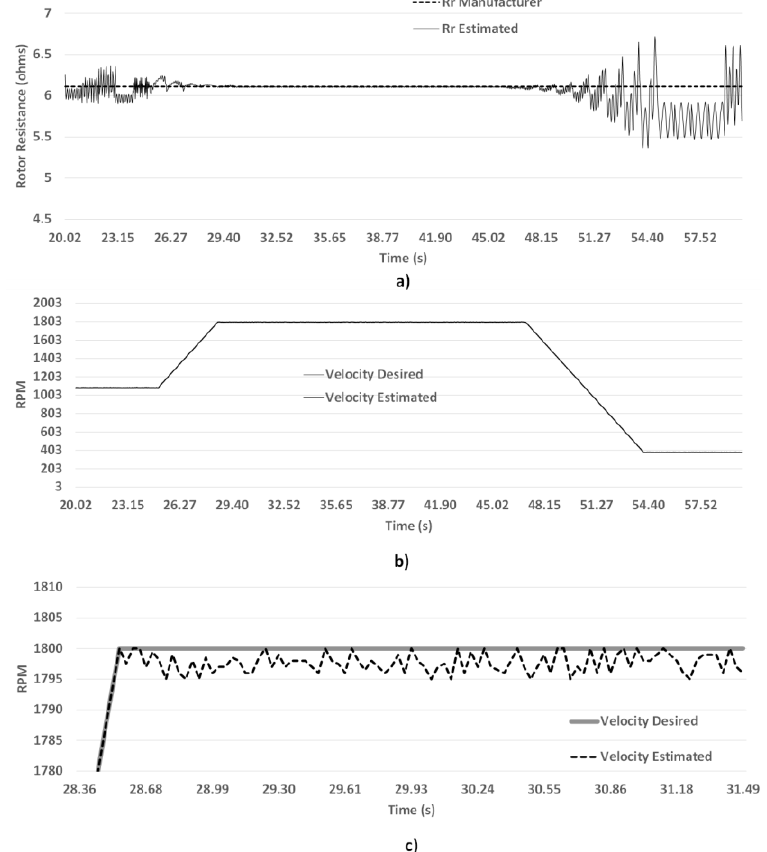
Figure 9. ( a ) Estimated R r vs. Desired R r ; ( b ) Estimated ω r vs. Desired ω r ; ( c ) Zoom to the